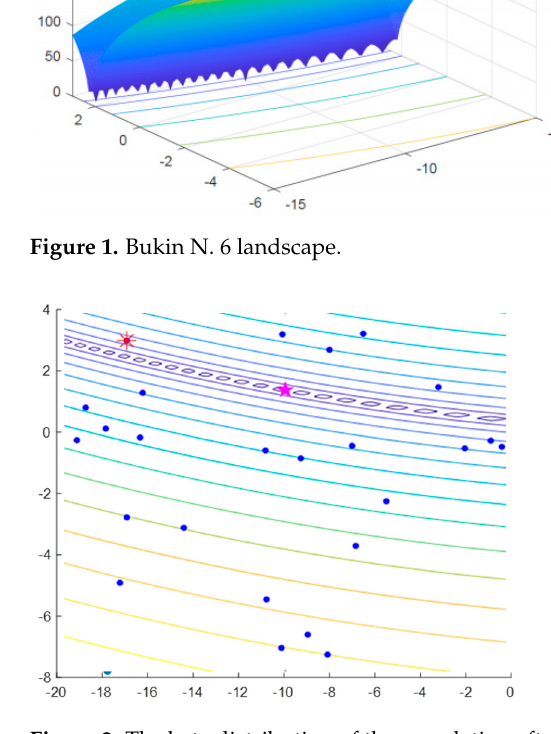
Figure 2. The beta distribution of the population after the first iteration.